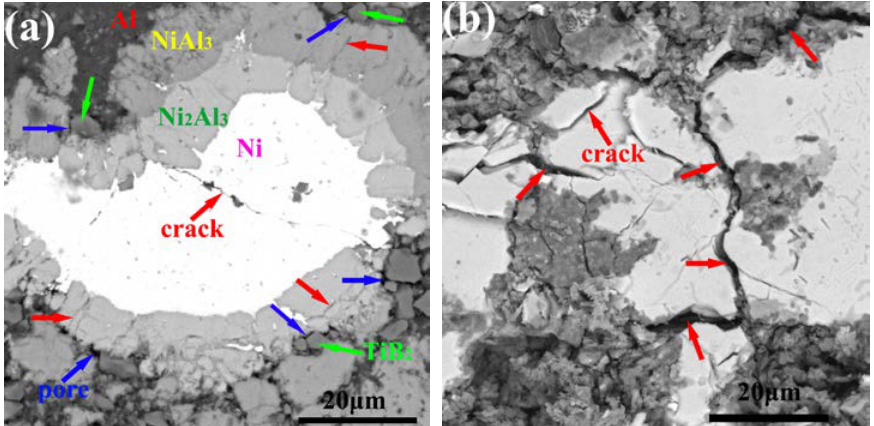
Figure 17. Microstructure of Ni/Al-TiB 2 composite coatings as-sprayed at 450 °C and annealed at ( a ) 650 °C for 10 h and ( b ) 650 °C for 30 h.